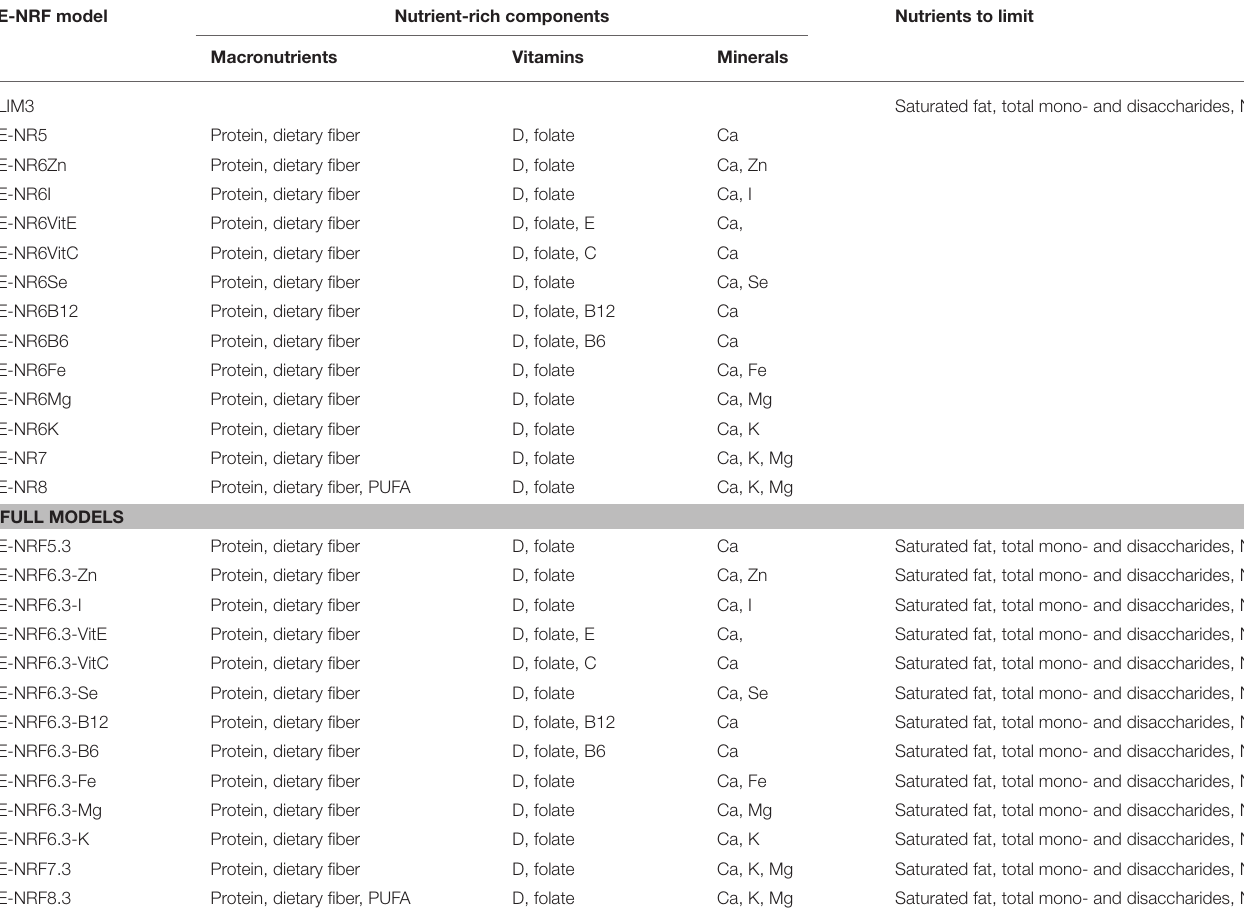
TABLE 1 | Elderly nutrient-rich food scores; models with nutrients to encourage, nutrients to limit, and full models including